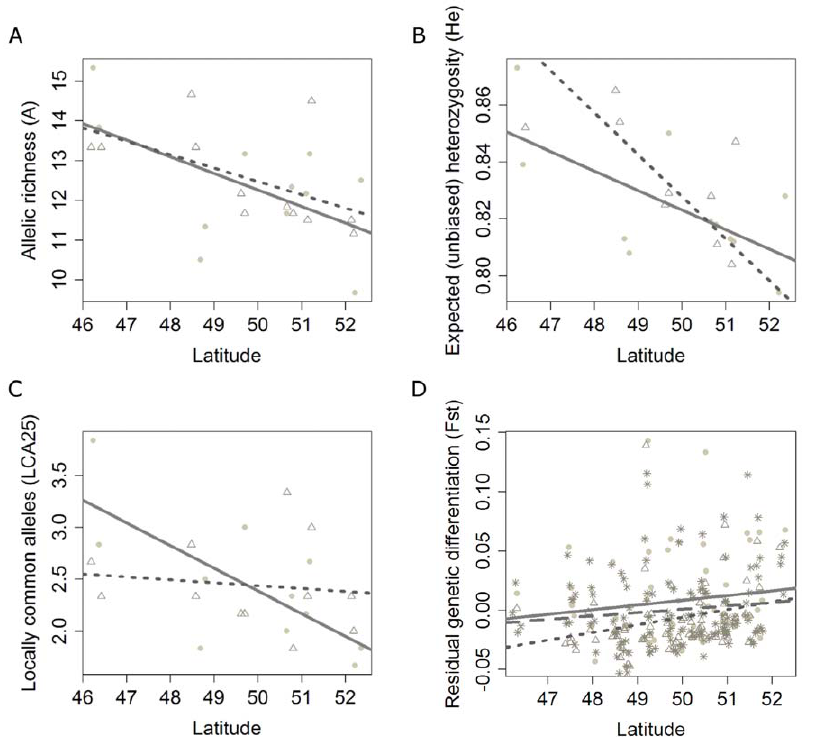
Figure 2. Genetic diversity and differentiation relative to latitude and landscape. (A) expected heterozygosity, (B) allelic richness, (C) locally common alleles (25%). Full line: linear regression for agricultural populations ( N ), discontinuous line: woodland populations ( D ). Significance levels are available in Table S3. (D) Residual population genetic differentiation. Full line: linear regression for agricultural-agricultural ( N ), dotted line: woodland-woodland ( D ), discontinuous line: agricultural-woodland (*) pairwise comparisons.